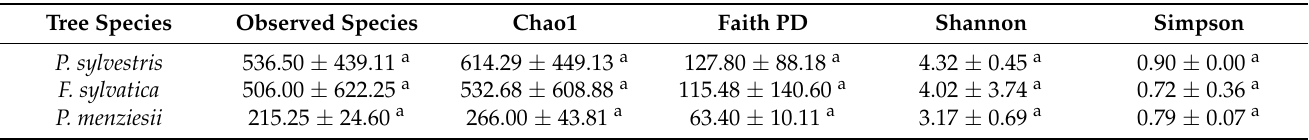
Table 5. Values of ecological indices for the tested variants (mean ± SD). Values followed by different lowercase letters are significantly different ( p < 0.05) between the tested